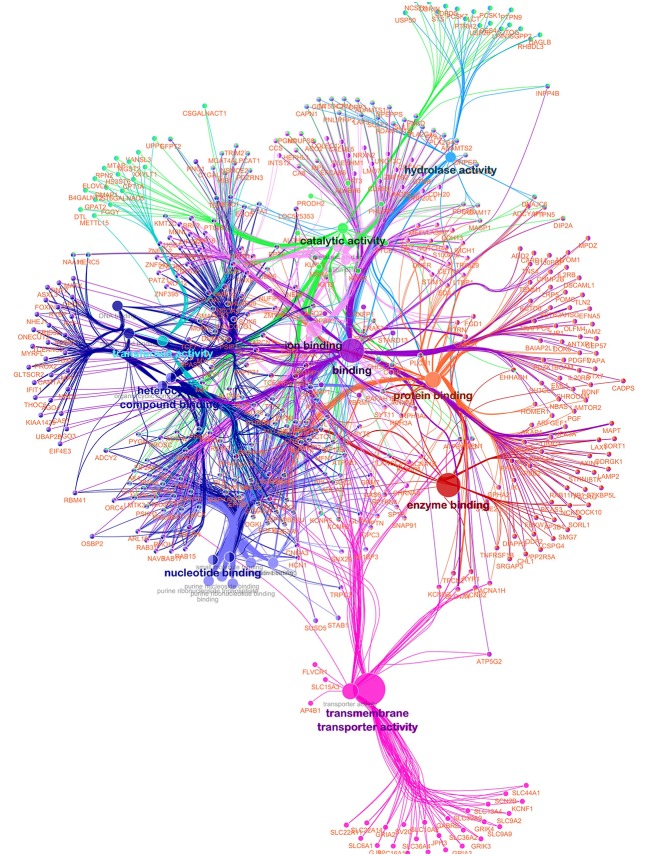
Functionally grouped network for meat quality complex in Angus cattle. Nodes represent functional terms linked based on their kappa score level (>0.3) with only the most significant term per group shown as a label. The node size represents the enrichment significance of the term. Only genes in common between two or more GO terms are used.